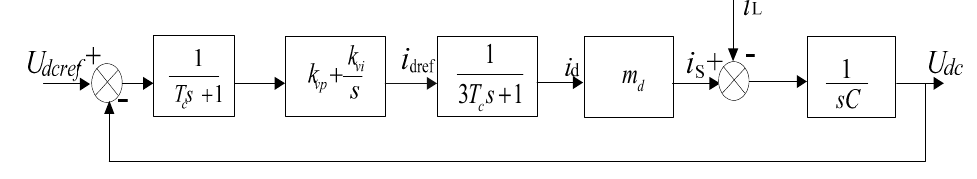
Figure 6. Dynamic block diagram of voltage loop.